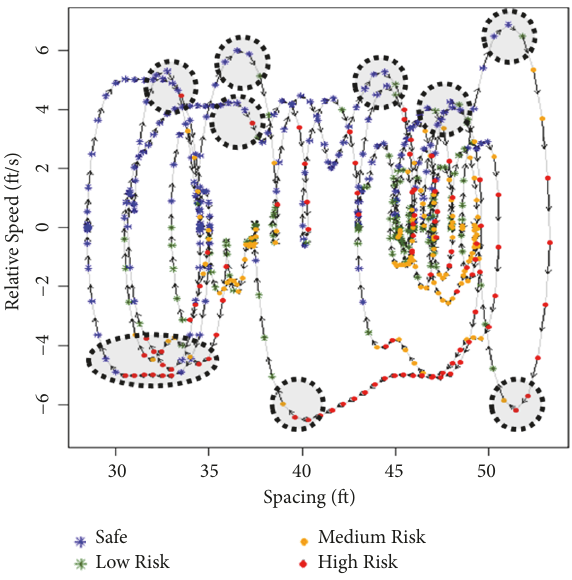
Figure 4: Collision risk estimated with the temporal spacing and relative speed (SHD).